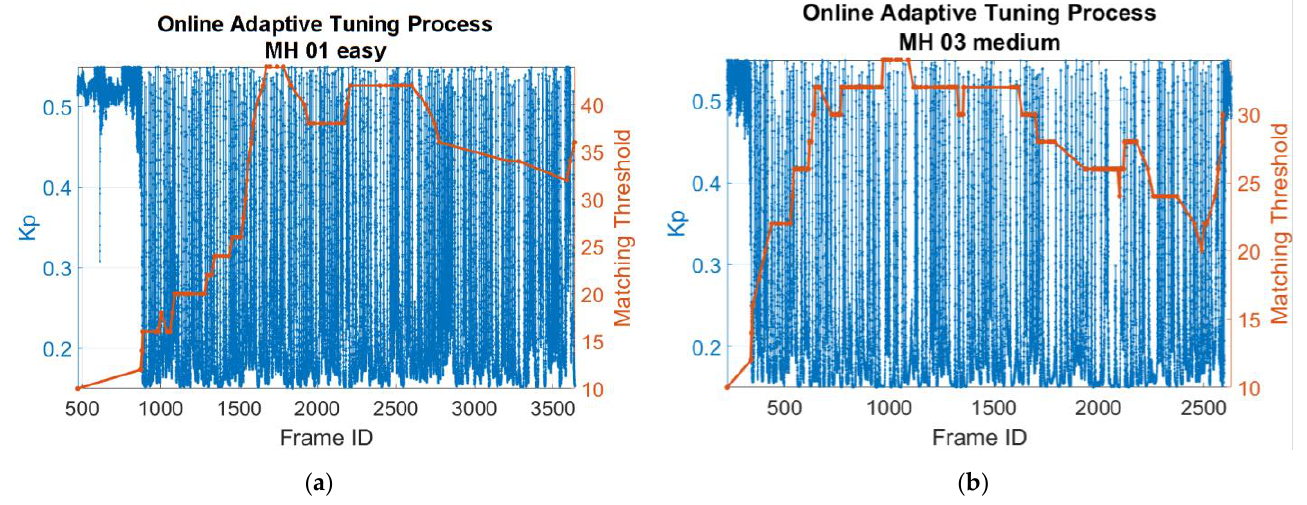
Figure 24. Adaptive tuning process of matching threshold and K p : ( a ) For MH_01_easy series; ( b ) For MH_03_medium